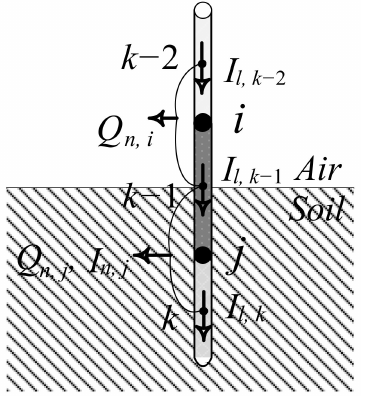
Figure 3. Segment at the interface between the air and the soil.